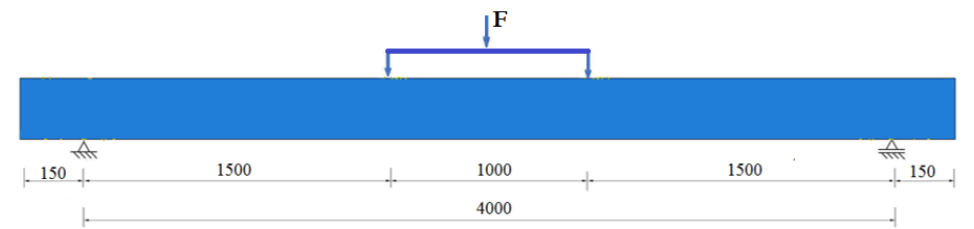
Figure 8. Boundary and loading condition of standardized model (measurements in mm).